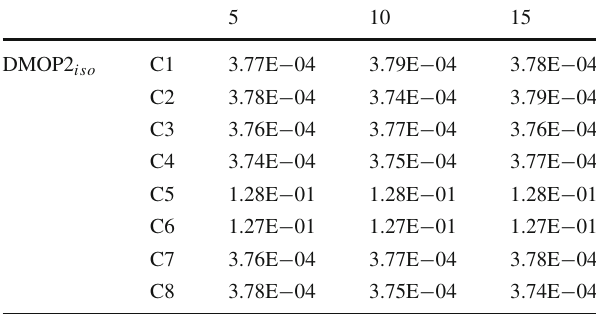
Table 6 The MIGD of different size of neighborhood 5 10 15 DMOP2 iso